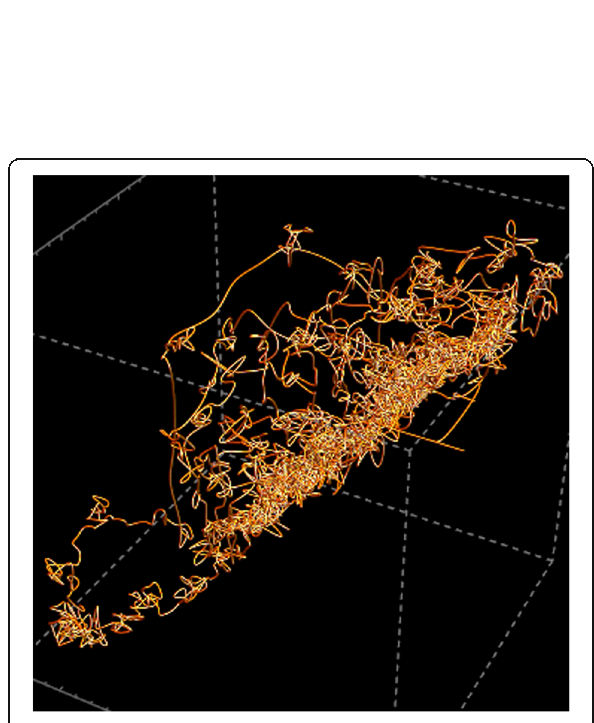
Fig. 14 Projection of the attractor for CNST _ e data from a higher dimension (perhaps an embedding dimension of 10) into three dimensions. The attractor has been constructed using a time delay of 30 days according to the method discussed in the “ The invariant measures ” section. See Hobbs and Ord (2015), pp. 227 – 228